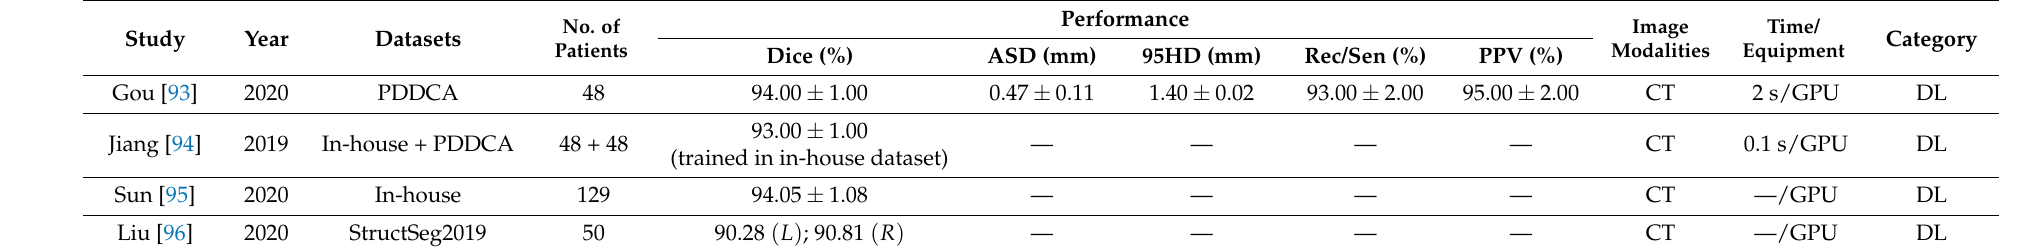
Table 10. Summary of attention strategies of deep learning-based